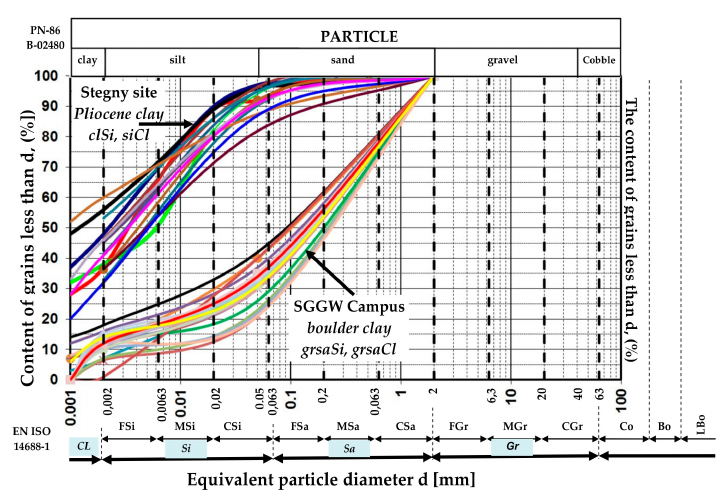
Figure 3. Grain size distribution of clay from the tested